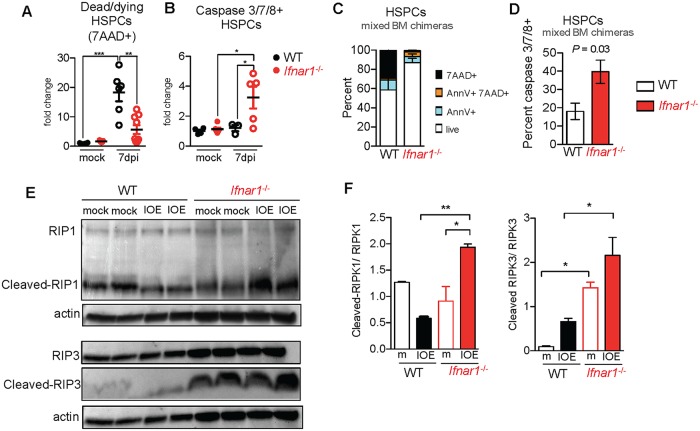
Type I IFNs induce caspase-independent HSPC death during IOE infection.(A) Fold change in dead/dying cell frequency within the CD48- HSPC population of WT and Ifnar1-/- mice 7 d.p.i. normalized to WT mock levels. n = 5–9 mice/group. (B) Fold change in the proportion of live HSPCs with active caspases 8 or 3/7 over mock mice. n = 3–6 mice/group. (C) Frequency of apoptotic (Annexin V+ 7AAD-), dying (Annexin V+ 7AAD+), and dead (Annexin V- 7AAD+) cells and (D) caspase 8 or 3/7-active cells (gated on live, 7AAD- cells) among WT and Ifnar1-/- HSPCs in mixed BM chimeric mice 7 d.p.i. n = 3 mice. (E) Detection of full length RIP1, cleaved RIP1, full length RIP3, cleaved RIP3, and actin in BM lysates of WT and Ifnar1-/- mock and IOE–infected mice 7 d.p.i. Lanes represent individual mice. (F) Fold change of cleaved RIP1 to full length RIP1 and cleaved RIP3 to full length RIP3 in WT and Ifnar1-/- mock (m) and IOE–infected mice, 7 d.p.i. *P < 0.05, **P < 0.001, ***P < 0.0001.